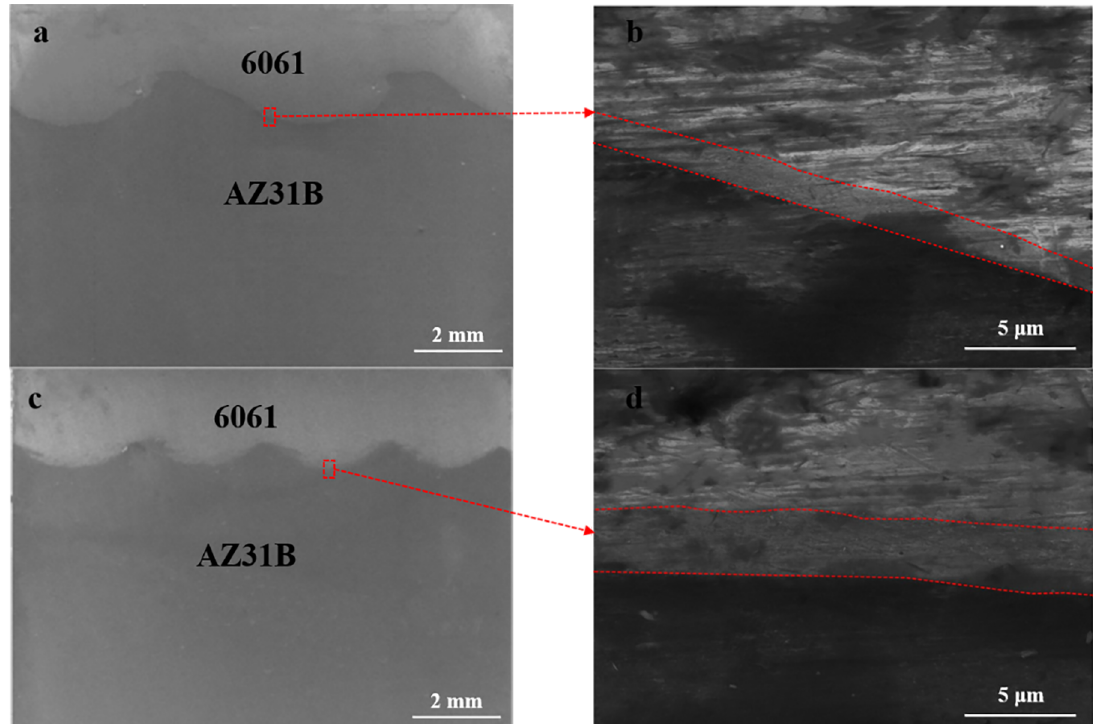
Figure 4. SEM images of the composite interfaces after explosive welding (a) big waveform (c) mini waveform.